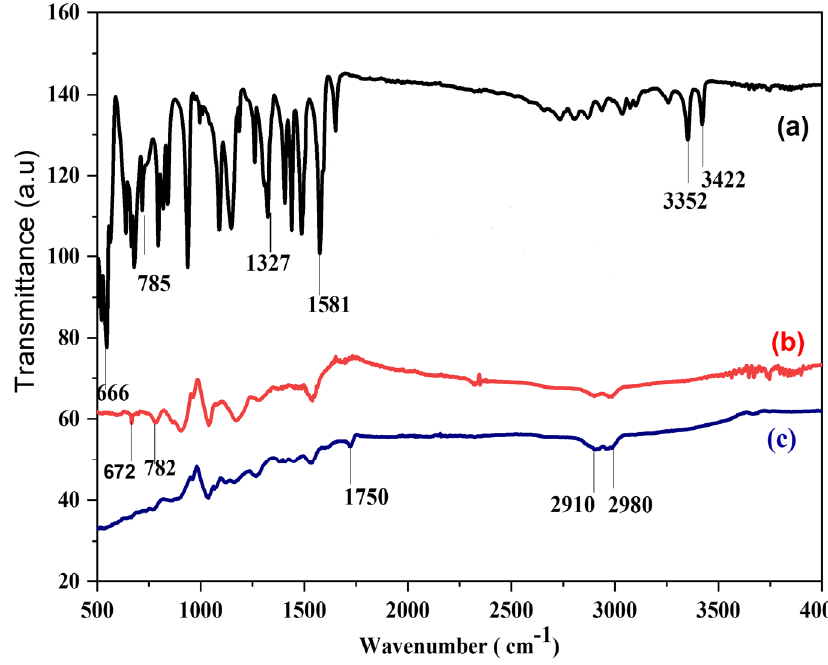
Figure 6. The FTIR spectra of the SDZ ( a ), PPy/SDZ ( b ), and MIP-OPPy ( c ) matrices. Table 1. FT-IR peak assignments for SDZ, PPy/SDZ, and MIP/OPPy. Matrices